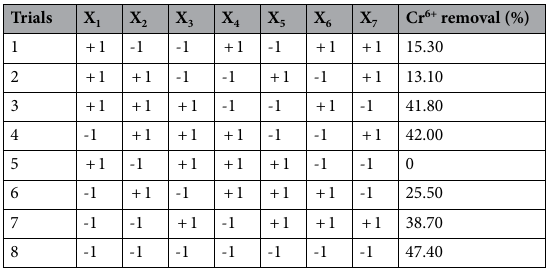
Table 2. Plackett–Burman design for the evaluation of significant variables affecting Cr 6+ removal by S. rochei ANH.